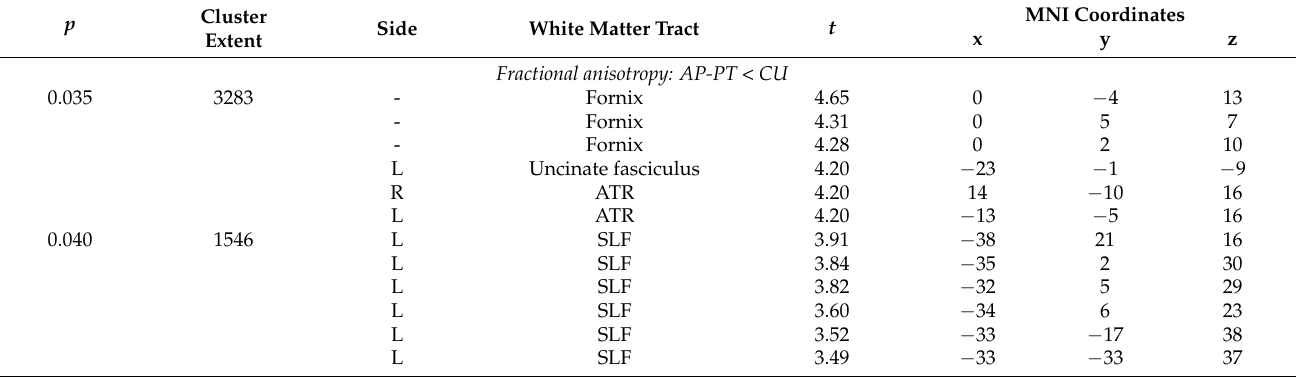
Table 2. Differences in DTI indices between AP-PT and CU groups ( p FWE <